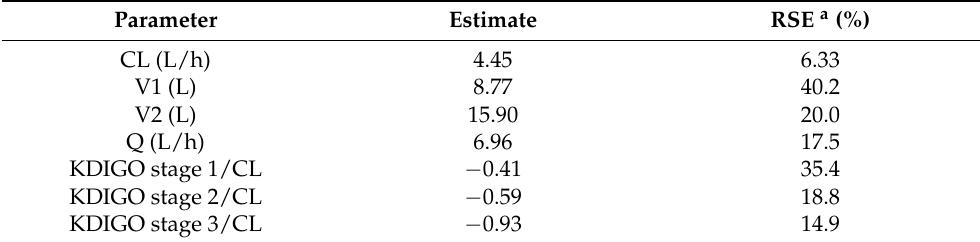
Figure 2. Prediction Corrected Visual Predictive Check of final model. Table 3. Population pharmacokinetic parameters of amikacin from the final